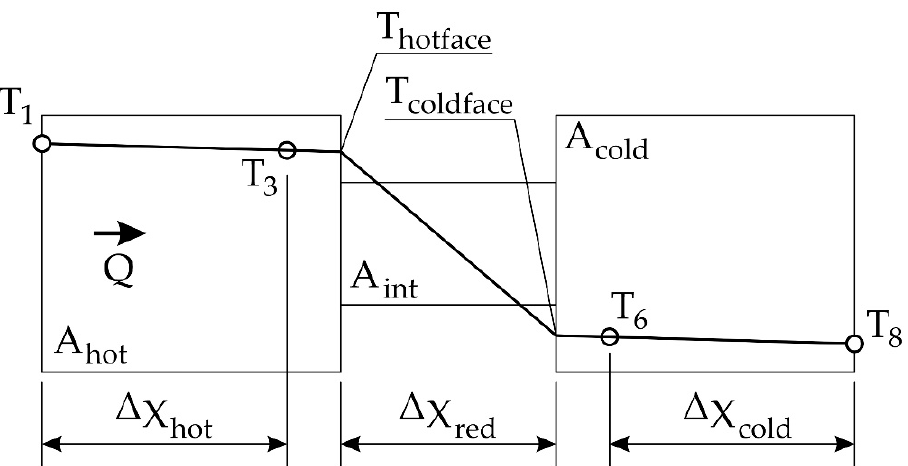
Figure 3. Theoretical temperature distribution in cross-sections. Where: X—length of the sections [m], A—is a cross-section [m 2 ], T (1,3,6,8)—temperature at measure points, T hotface , T coldface —calculated temperature at boundary of the layer.